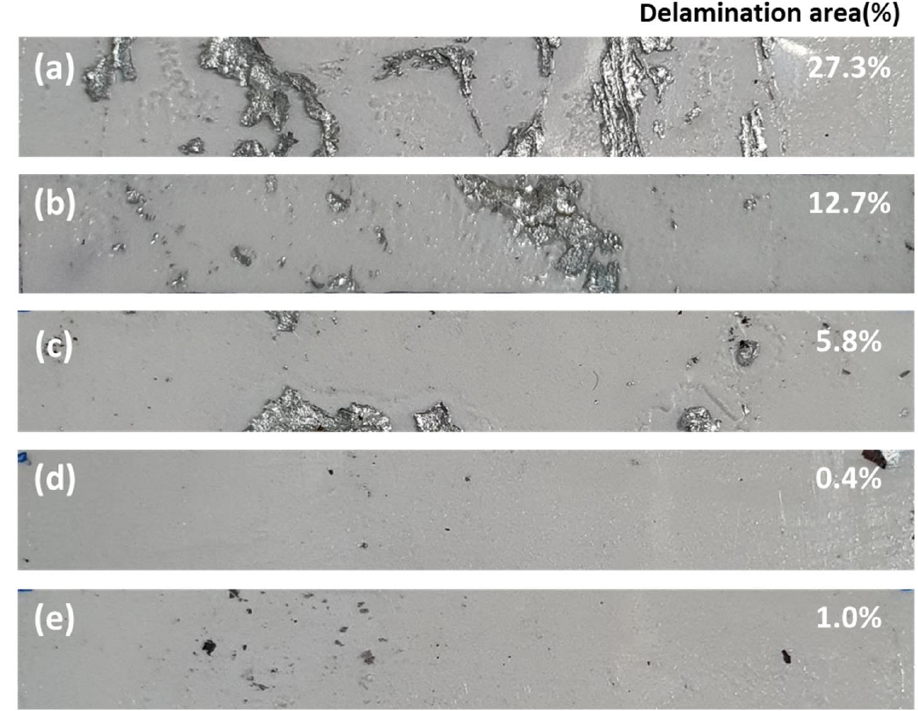
Figure 8. T ‐ bending test images of the Zn–1Mg–1Al hot ‐ dip ‐ coated steel with respect to the flux Figure 8. T-bending test images of the Zn–1Mg–1Al hot-dip-coated steel with respect to the flux composition: (a) normal flux, (b) 10% SnCl 2 , (c) 20% SnCl 2 , (d) 30% SnCl 2 , and (e) 40% SnCl 2 . composition: ( a ) normal flux, ( b ) 10% SnCl 2 , ( c ) 20% SnCl 2 , ( d ) 30% SnCl 2 , and ( e ) 40% SnCl 2